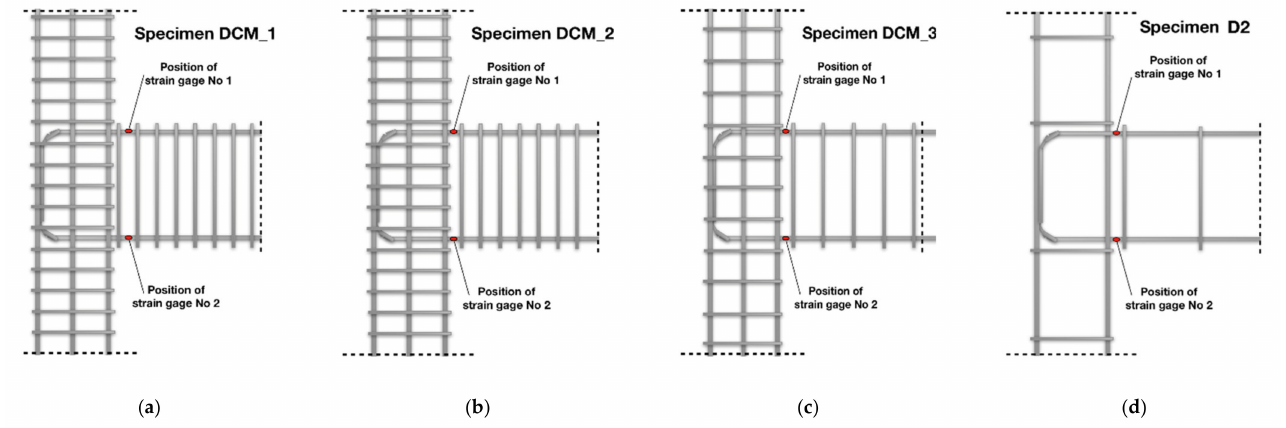
Figure 7. Location of the strain gauges: Subassemblages ( a ) DCM _1, ( b ) DCM _2, ( c ) DCM _3, and ( d ) D 2.